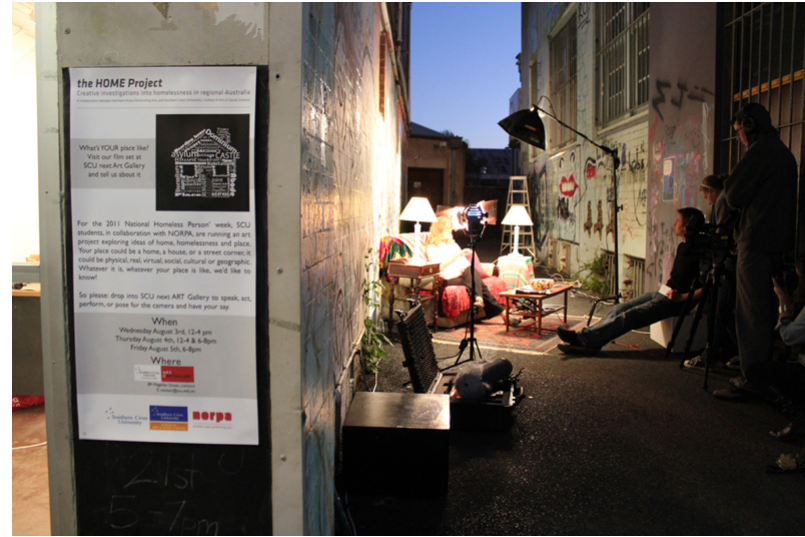
Figure 3: The laneway film set for ‘Lounging